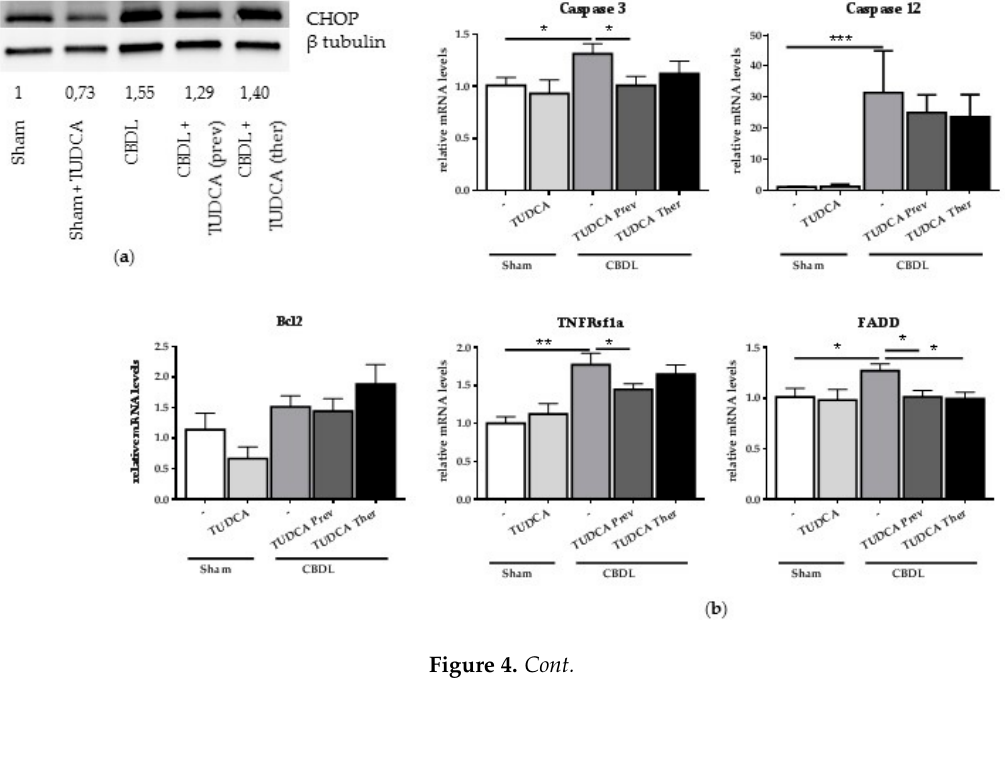
Figure 4. Cont. Figure 4.